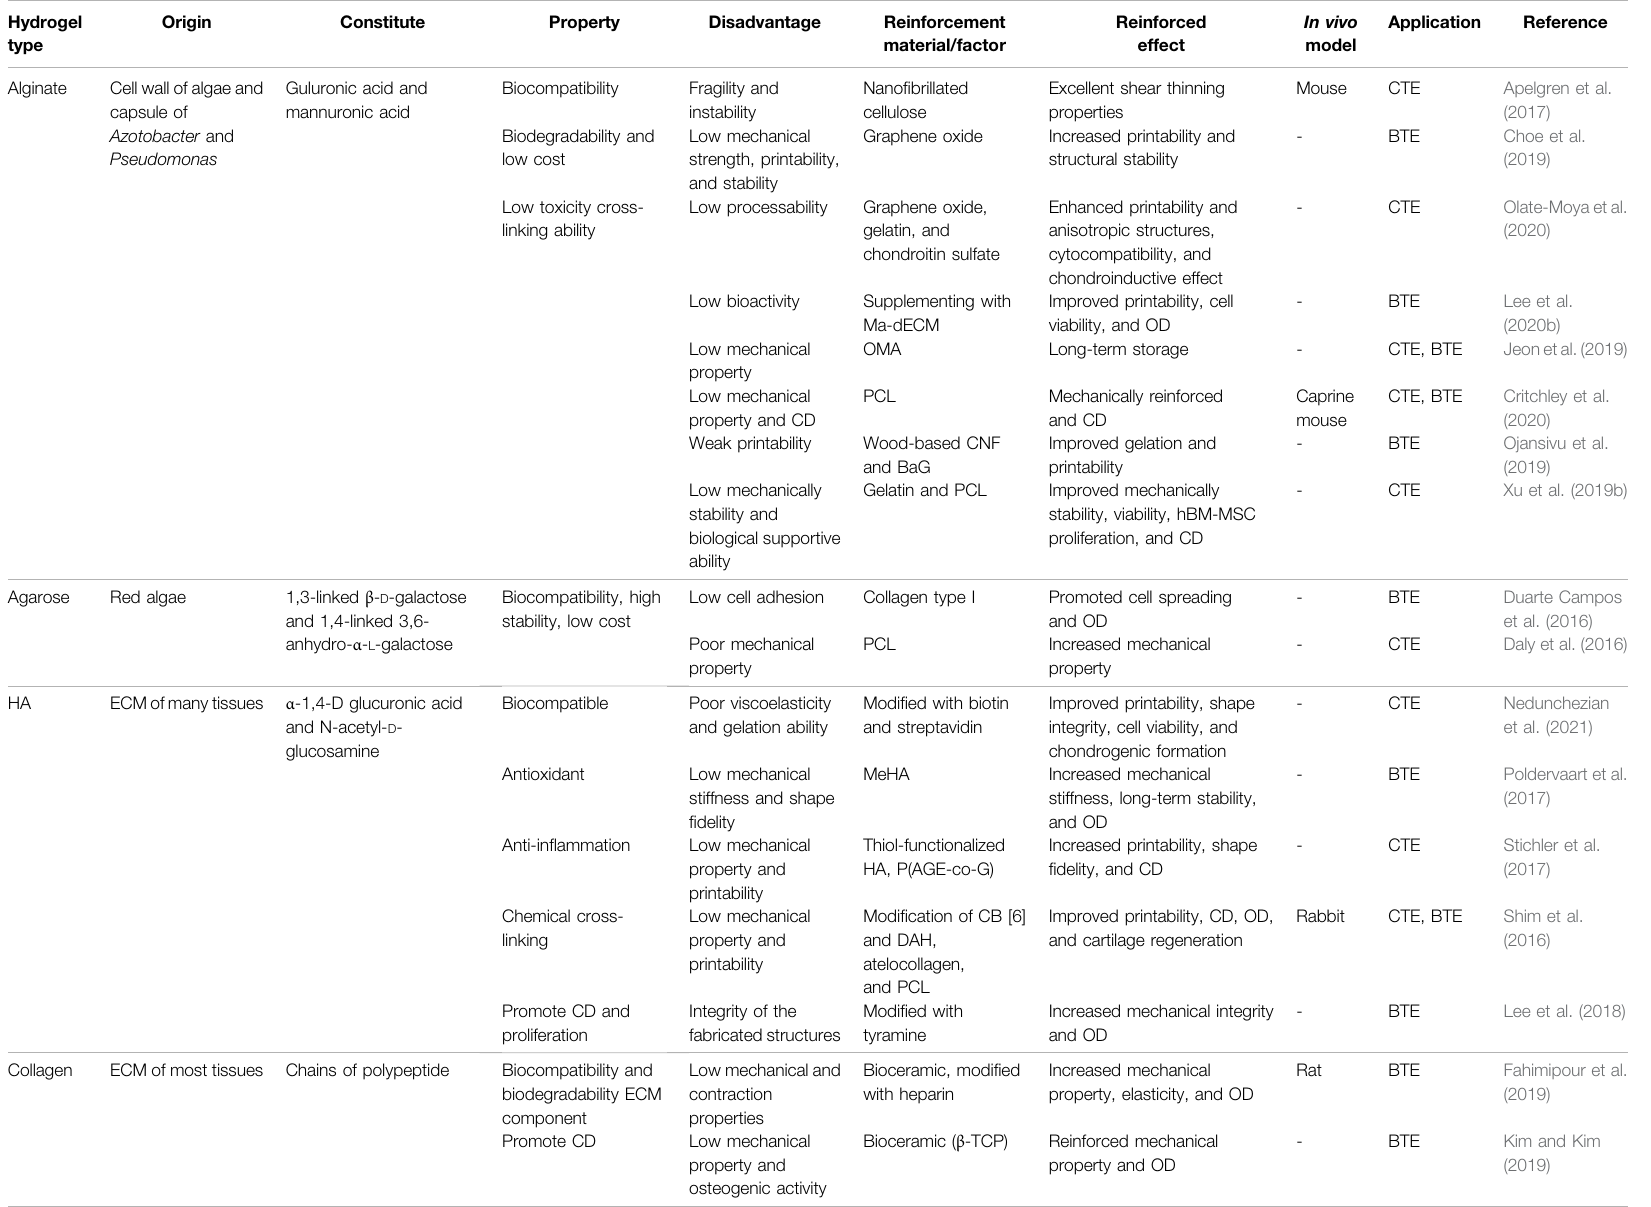
TABLE 2 | Characteristics of various hydrogels and applications in CTE and